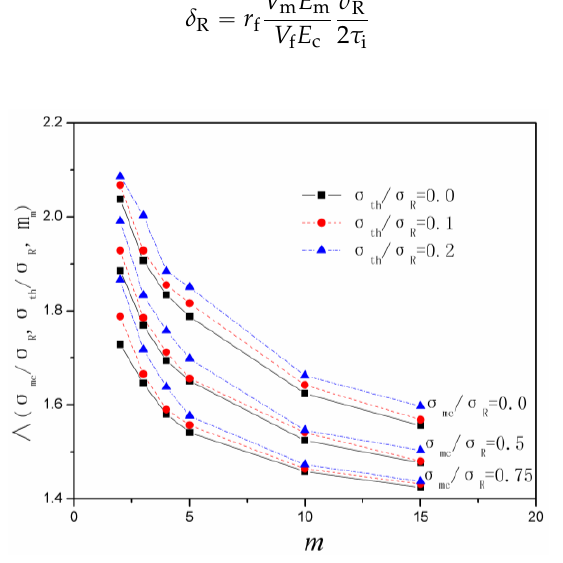
Figure 2. The final nominal matrix crack spacing versus matrix Weibull modulus of various σ mc / σ R and σ th / σ R .